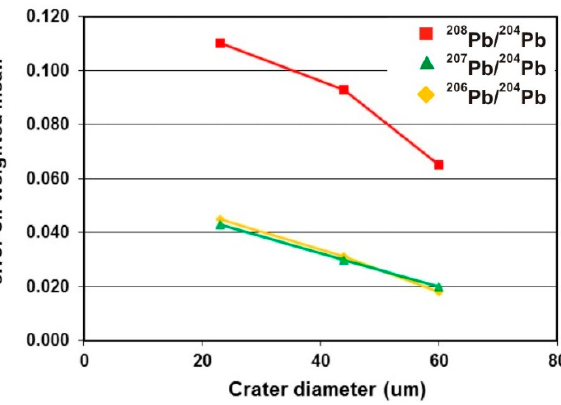
Figure 3. Plot of the error on weighted mean of Pb isotopic ratios vs. crater size (sample 62-55-115, Caribou deposit).